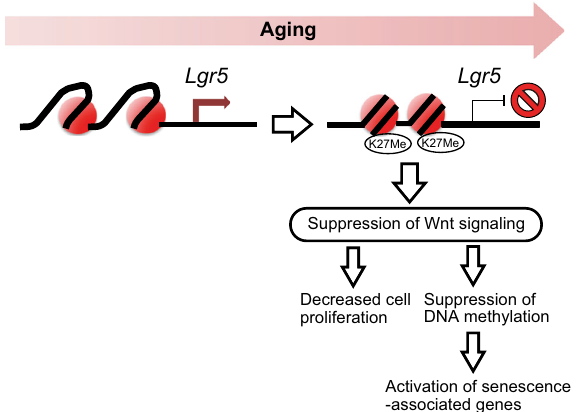
Fig. 5 Possible mechanism for epigenetic silencing of Lgr5 and induction of senescence in intestinal epithelial organoids derived from aged mice. The stem cell marker Lgr5 is substantially expressed in young intestinal epithelial organoids, but is epigenetically silenced by histone H3K27 trimethylation in organoids from aged intestinal epithelium. Since Lgr5 is an activator of the Wnt